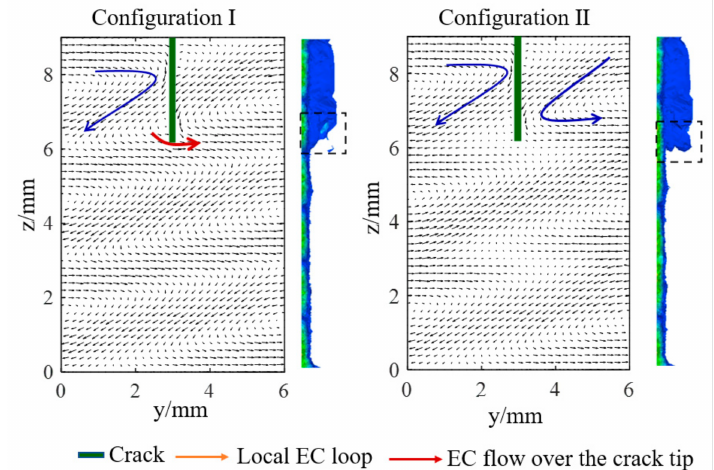
Figure 7. EC vector and cloud picture when the crack is at